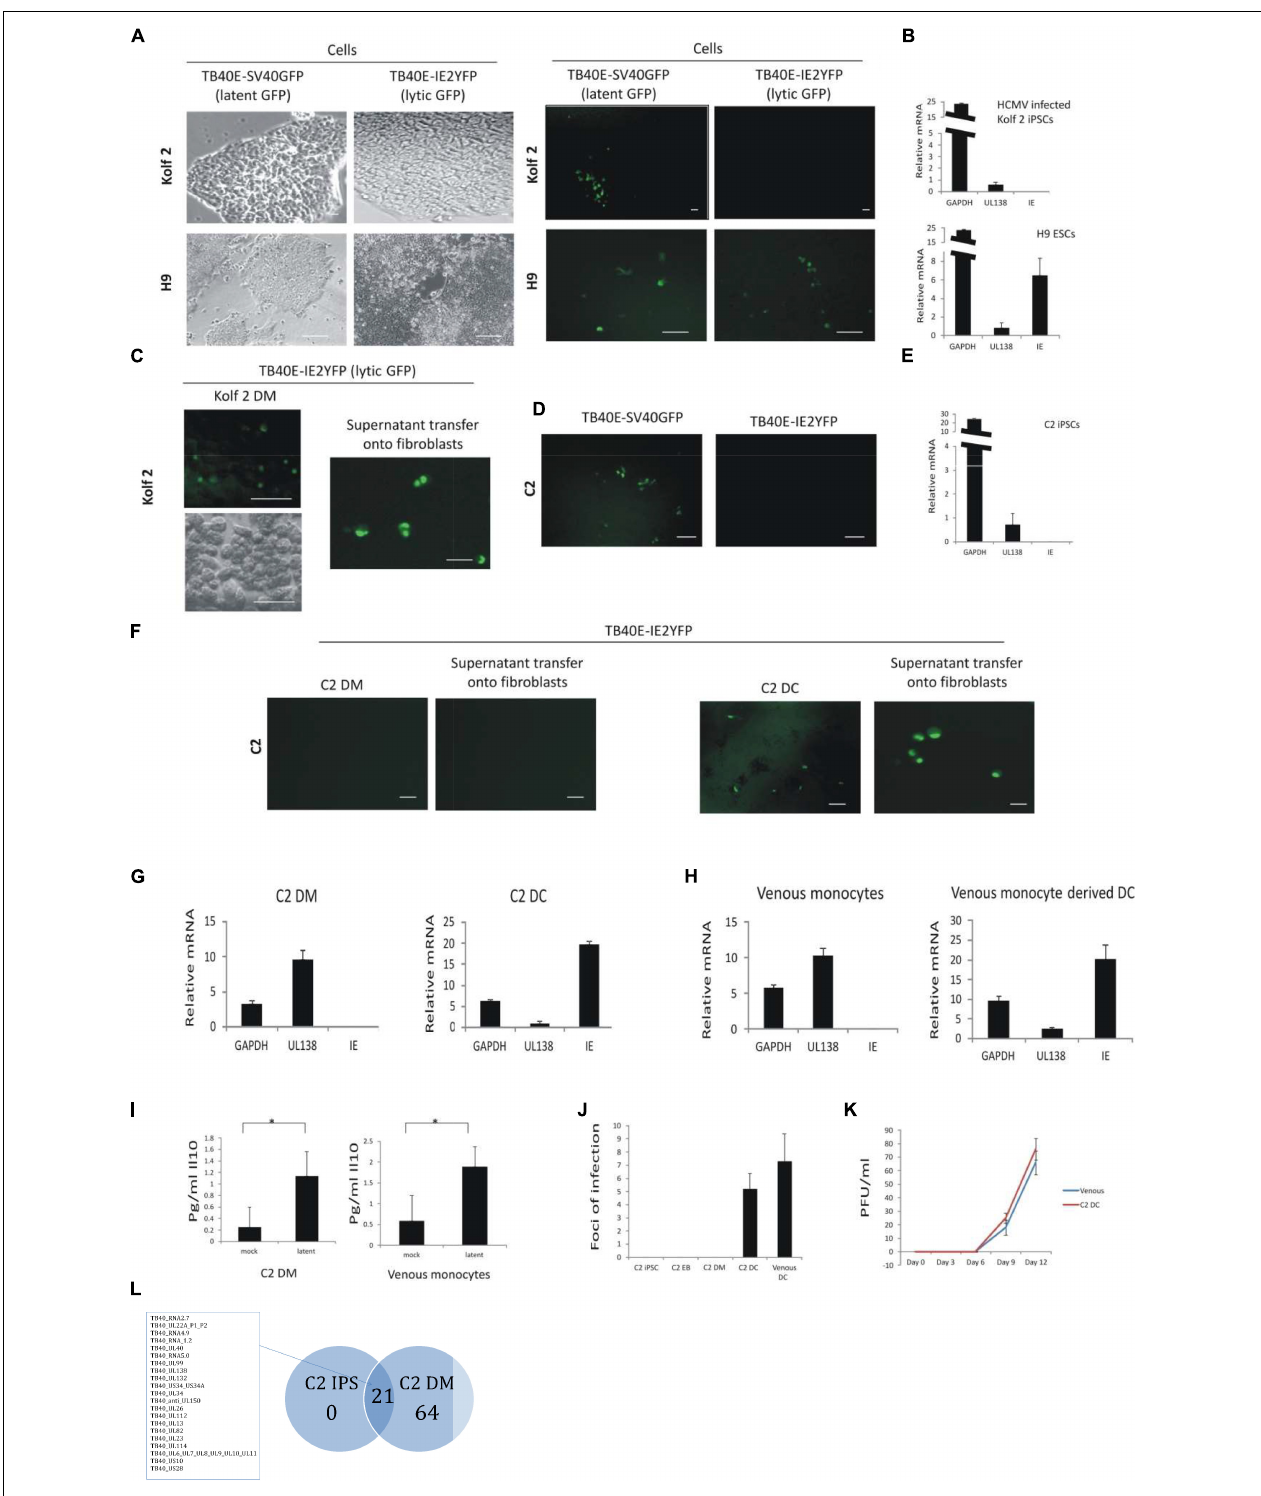
FIGURE 1 | C2 and Kolf2 cells can support a latent infection but only C2 cells maintain latent carriage down the myeloid lineage and can support viral reactivation. Kolf2 and H9 were infected with either TB40E-SV40GFP (MOI 5) (which results in GFP expression in both lytically and latently infected cells) or TB40E-IE2YFP (MOI 5) (which results in GFP expression only in lytically infected cells) and analyzed by fluorescence microscopy at 4 days post infection (brightfield and fluorescence images are shown) (A) or RT-qPCR of the SV40GFP (MOI 5) infected cells (B) . Additionally, after differentiation to EBs, monocytes derived from Kolf2 cells were infected